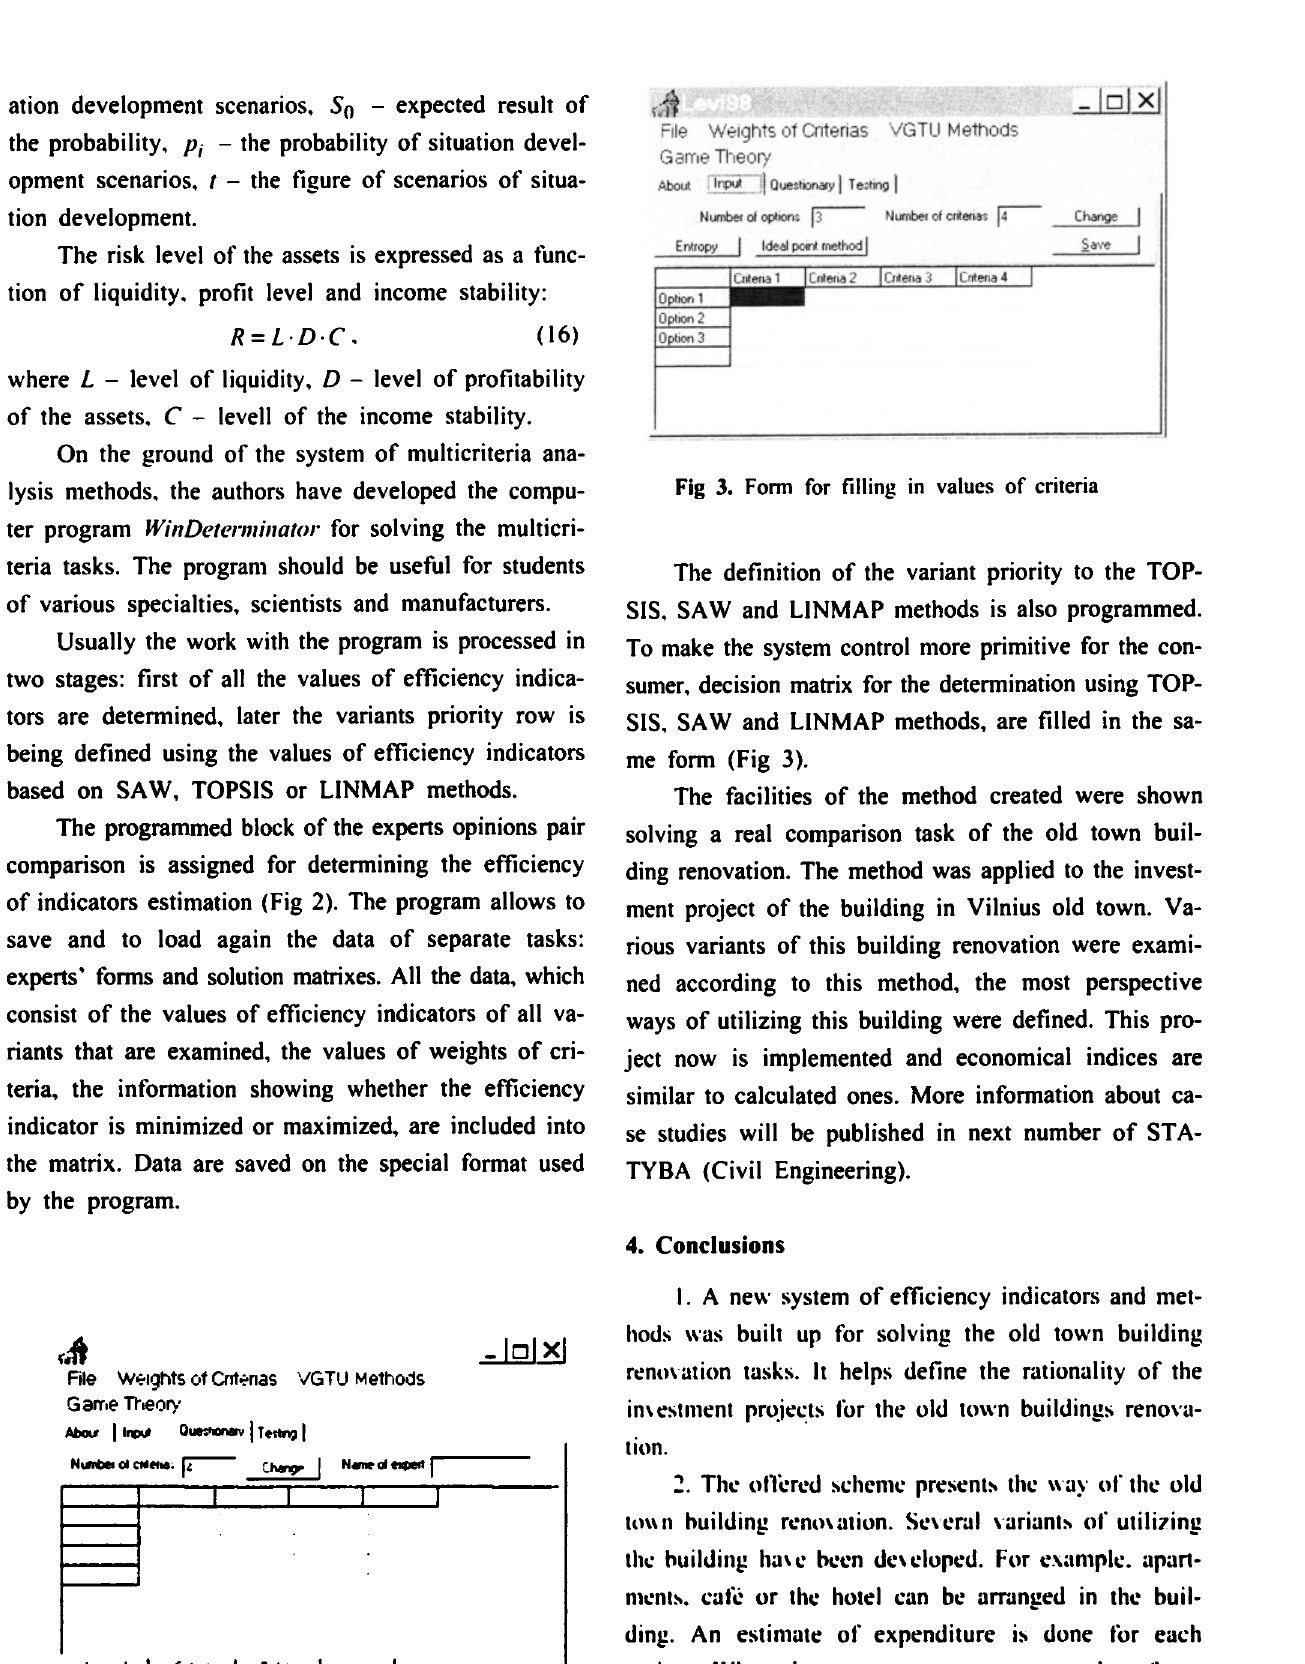
Fig 2. Form for filling in questionary results